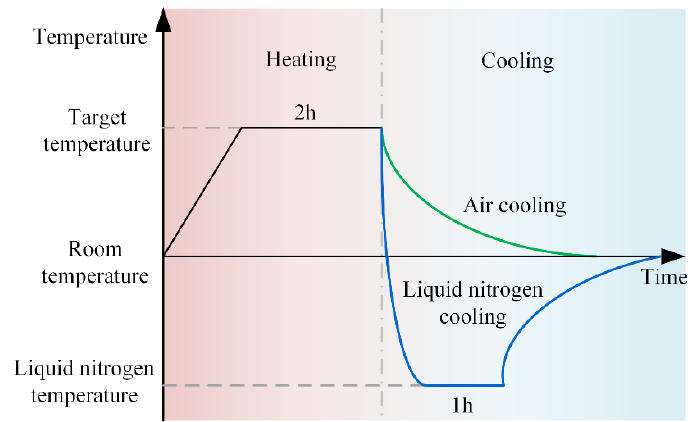
Figure 2. Thermal treatment schedule.